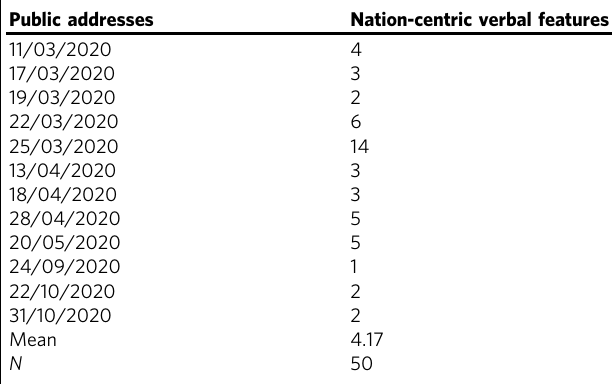
Table 2 Verbal nation-centric semantic features.